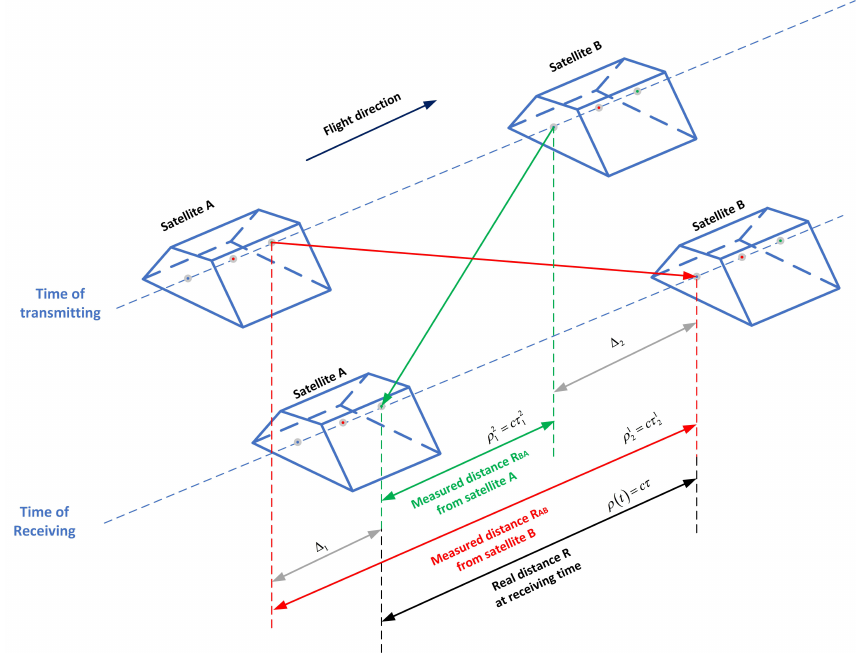
Figure 3. Schematic diagram of light-time correction. The black arrow denotes the real distance ρ ( t ) at receiving time, while the red and green arrows denote the measured distance ρ 1 Figure 3 illustrated the instantaneous range ρ ( t ) = c τ at the same nominal time t , and the phase-derived ranges ρ 1